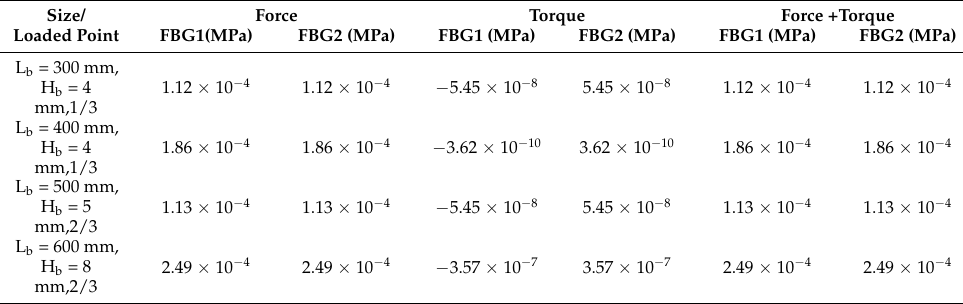
Table 6. Absolute value of the maximum equivalent